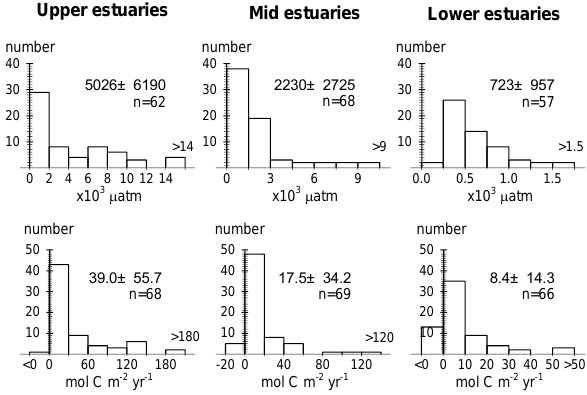
1 Fig.2. CO 2 flux in (a) upper, (b) mid and (c) lower estuaries.2 Fig. 2. CO 2 flux in (a) upper, (b) mid- and (c) lower estuaries.